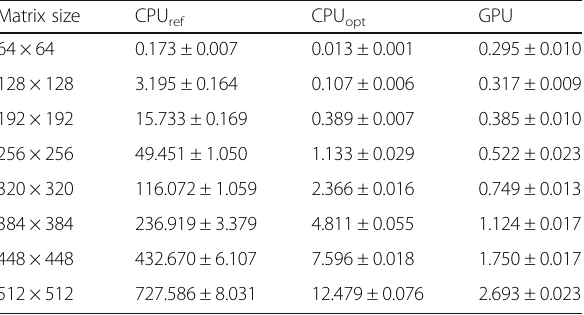
Table 1 Average time for each individual resolution step implemented as a convolution function of the band-limited kernel Matrix size